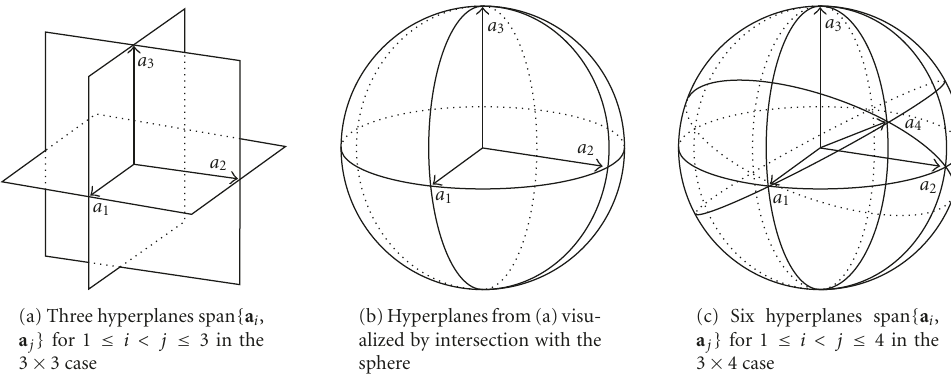
Figure 1: Visualization of the hyperplanes in the mixture space { x ( t ) } ⊂ R 3 . Due to the source sparsity, the mixtures are generated by only two matrix columns a i , a j , and are hence contained in a union of hyperplanes. Identification of the hyperplanes gives mixing matrix and sources.